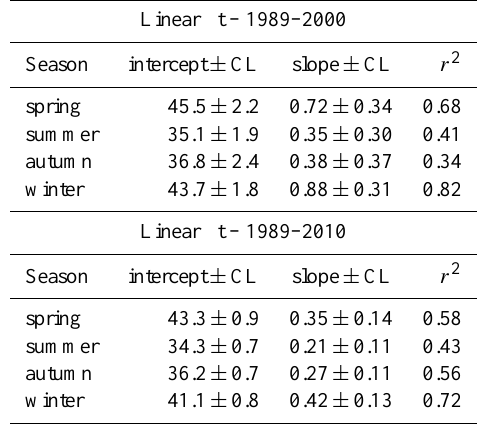
Table 3. Parameters of linear regression using least-squares fits to the Mace Head data set for the indicated time periods. CL indicates the 95% confidence limits of the respective parameters, and r is linear correlation coefficient. Units are ppbv and ppbvyr − 1